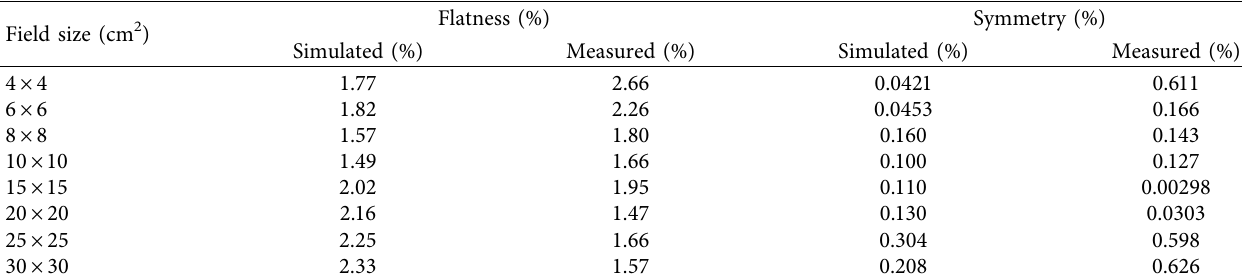
Table 7: The measured and calculated data of flatness and symmetry of FF beams. (The uncertainties of simulated flatness in FF mode of 4 × 4, 6 × 6, 8 × 8, 10 × 10, 15 × 15, 20 × 20, 25 × 25, 30 × 30cm 2 fields were as follows: 0.4%, 0.6%, 0.7%, 0.9%, 1.2%, 1.4%, 1.6%, 2% ( k � 2). The uncertainties of simulated symmetry in FF mode of 4 × 4, 6 × 6, 8 × 8, 10 × 10, 15 × 15, 20 × 20, 25 × 25, 30 × 30cm 2 fields were as